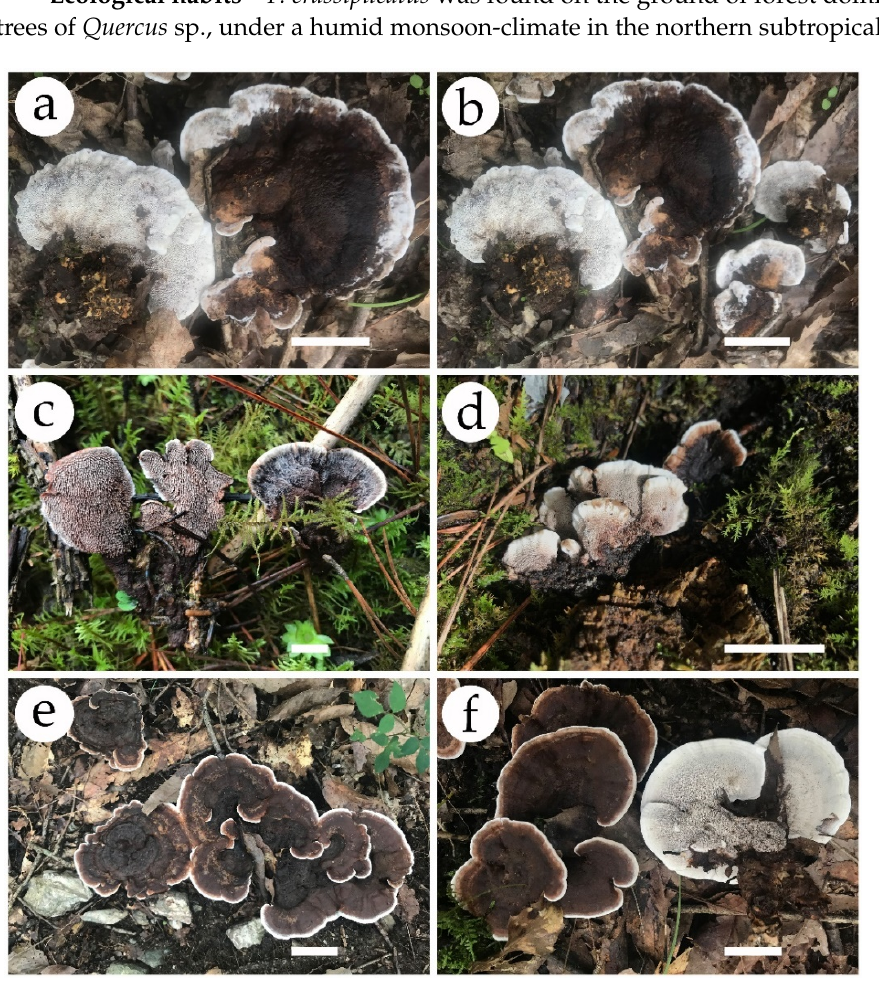
Figure 3. Basidiomata of Phellodon species. ( a , b ) P. crassipileatus , ( c , d ) P. griseofuscus , and ( e , f ) P. perchocolatus. Scale bars: 2 cm.